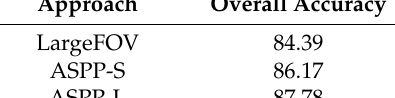
Figure 10. ( a ) LargeFOV: Conv6, Conv7 and Conv8 layers contain a single branch; ( b ) ASPP: Conv6, Conv7 and Conv8 layers contain four branches. Table 8. Effect of LargeFOV, ASPP-S and ASPP-L on the Vaihingen dataset.